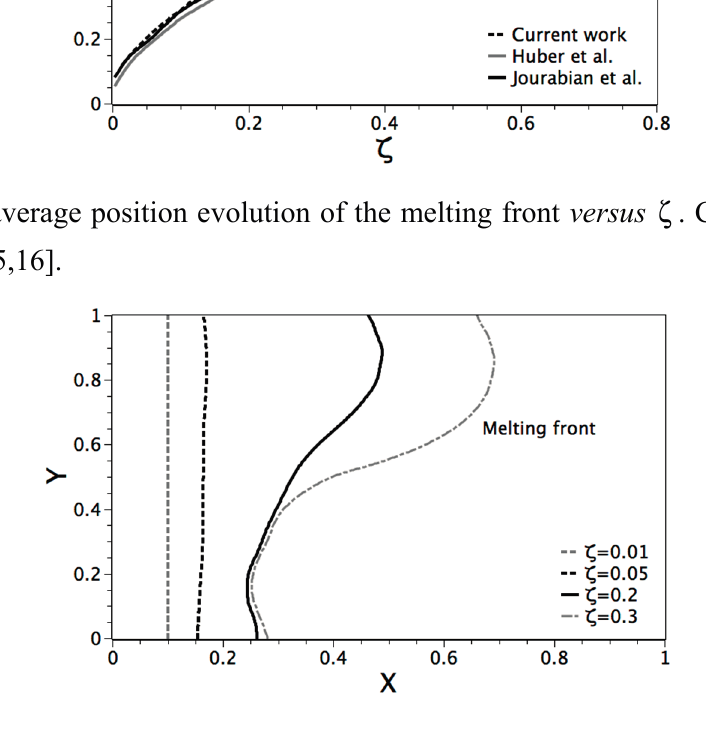
Figure 3. Position and shape of the melting front at different dimensionless times ζ